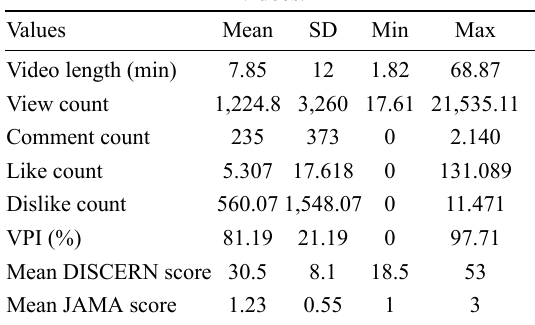
Fig. 5. View counts according to uploader category. Table 1. Overall characteristics of the examined YouTube videos .